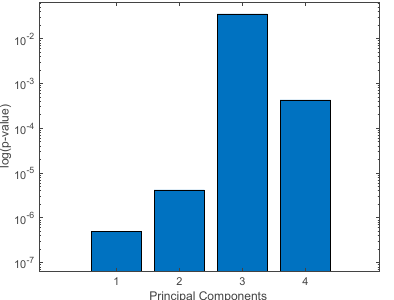
Figure 7. Plot of the logarithm of the probability of null hypothesis ( p -value) returned by a non-parametric Kruskal–Wallis rank sum. The p -value is related to the largest separation between at least two of the nine groups.